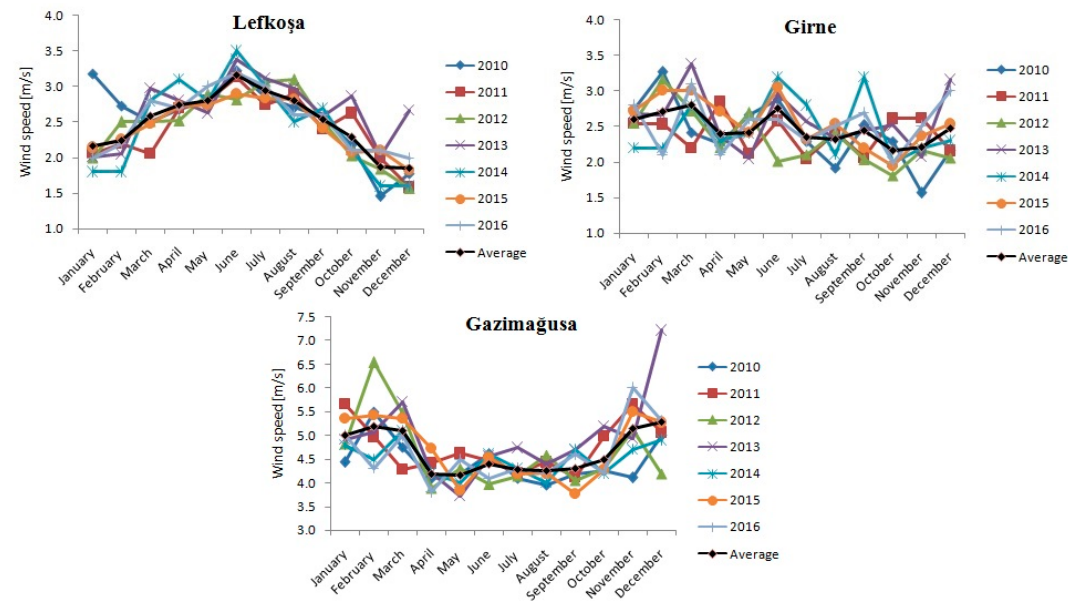
Figure 3. Monthly variation of the mean wind speed at a 10 m height.